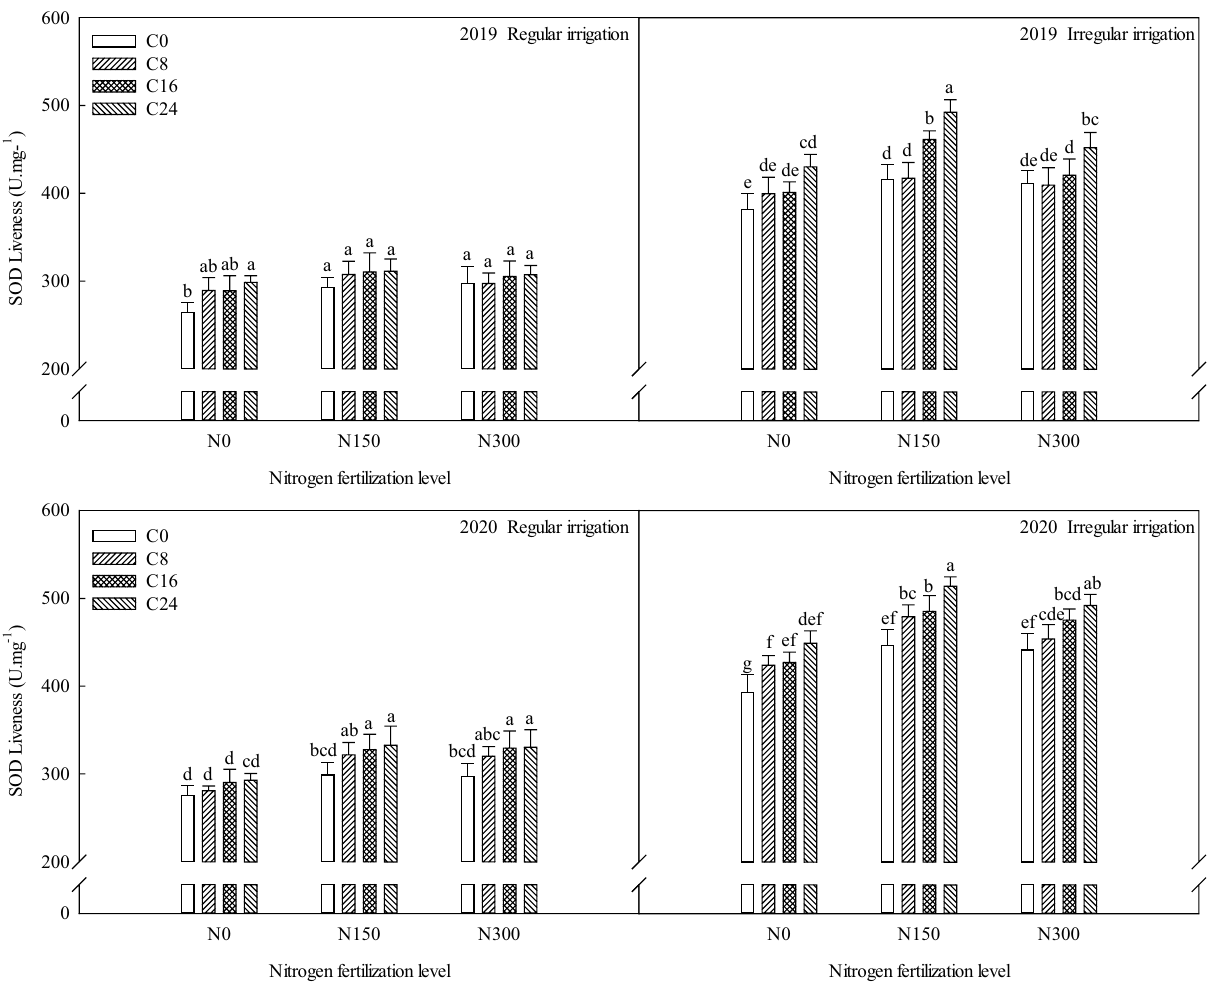
Figure 2. Effects of bio-char and nitrogen fertilizer on SOD activity of maize under different irrigation